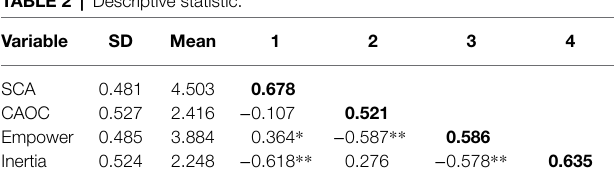
TABLE 2 | Descriptive